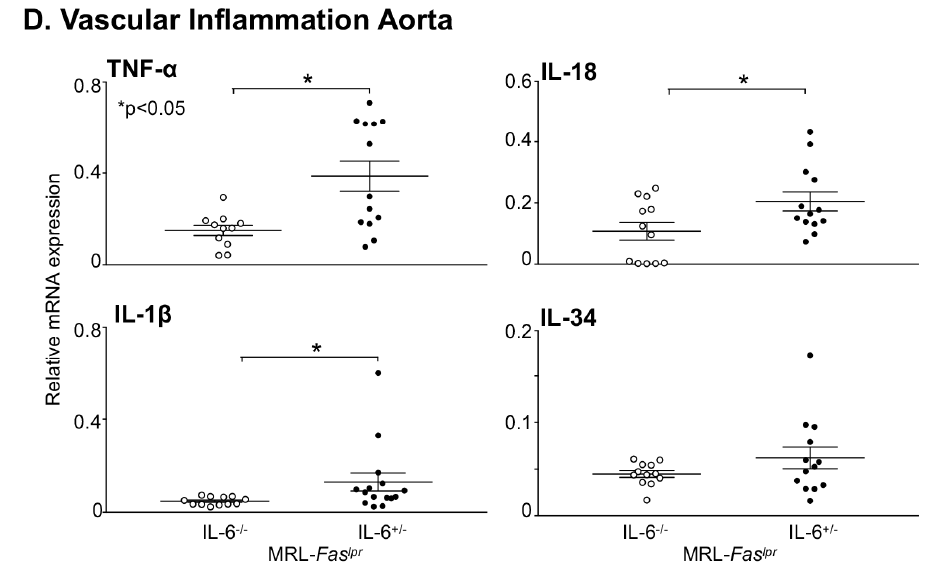
Figure 4. Deficiency of IL-6 results in amelioration of vascular inflammation determined in MRL- Fas lpr mice. ( A ) Serum IL-6 expression evaluated by ELISA in the serum of Il6 − / − , Il6 +/ − and Il6 +/+ MRL- Fas lpr mice ( n = 5 per group). ( B ) Evaluation of intra-renal vascular/perivascular of arterioles and arteries, periglomerular and interstitial in Il6 − / − MRL- Fas lpr mice (3 and 5 mo of age) compared MRL- Fas lpr mice, n = 6–10 per group. ( C ) Infiltration of the vessel wall with CD68 + macrophages and CD4 + T cells determined by RTQ-PCR at 3 mo of age in IL-6 − / − MRL- Fas lpr mice compared to MRL- Fas lpr mice. ( D ) Expression of TNF- α , IL-1 β , IL-18, and IL-34 in the aorta of IL-6 − / − MRL- Fas lpr mice compared to MRL- Fas lpr to mice at 3 mo of age, n = 10–15. A single data point refers to a single animal. Values are means ± SEM. Statistical analysis using Mann–Whitney U Test.